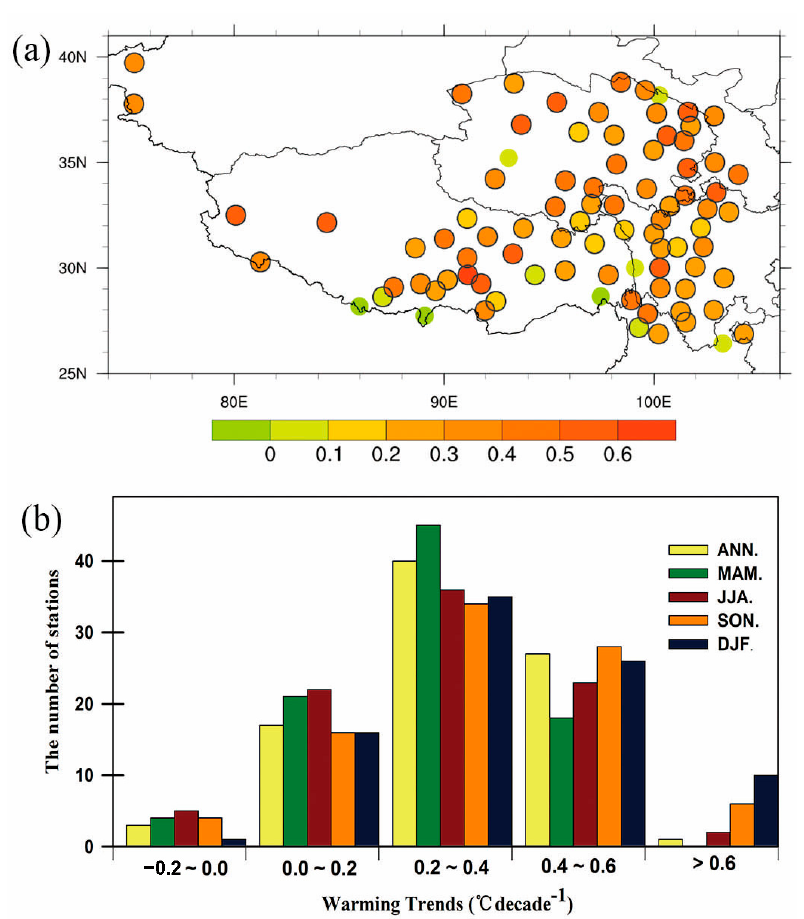
Figure 4. Spatial distribution and seasonal difference in mean temperature during 1971–2015. ( a ) Spatial distribution of annual temperature variations in 88 stations (points with blue circles indicate that they are significant at the 0.01 level); ( b ) The number of stations with different variation trends in annual and seasonal scales.